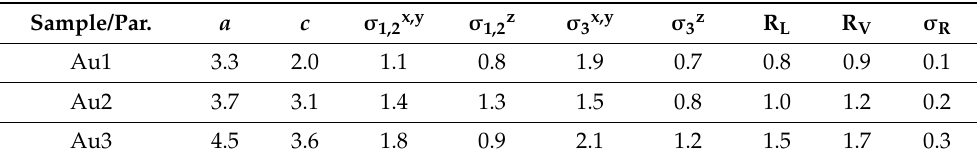
Table 2. Parameters of the Au QD lattices found by GISAXS analysis. a and c are the lateral and vertical separation of Au NPs, respectively; σ 1–3x,y,z are the deviation parameters, and R L and R V are the Au NP lateral and vertical radii respectively. All values are given in nm.